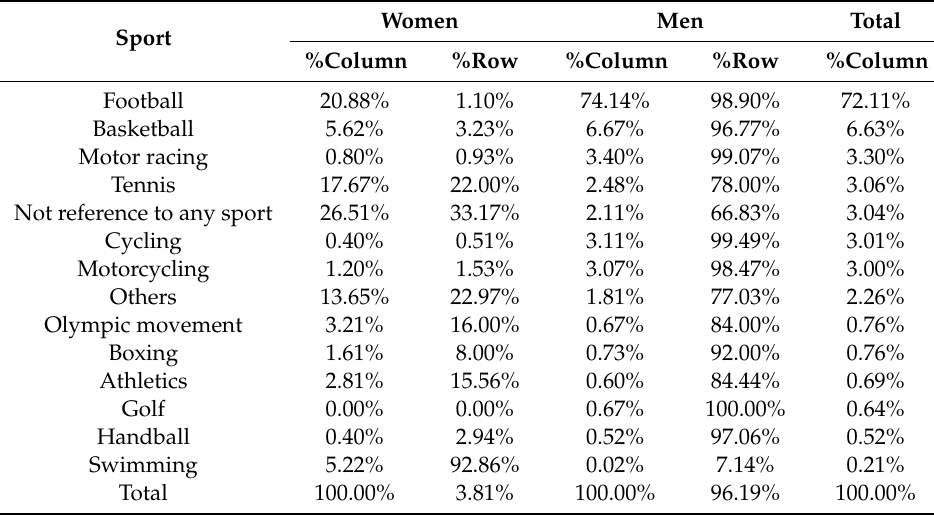
Table 5. Sample distribution of gender according to the sport mentioned in the tweets (n = 6544). Women Sport